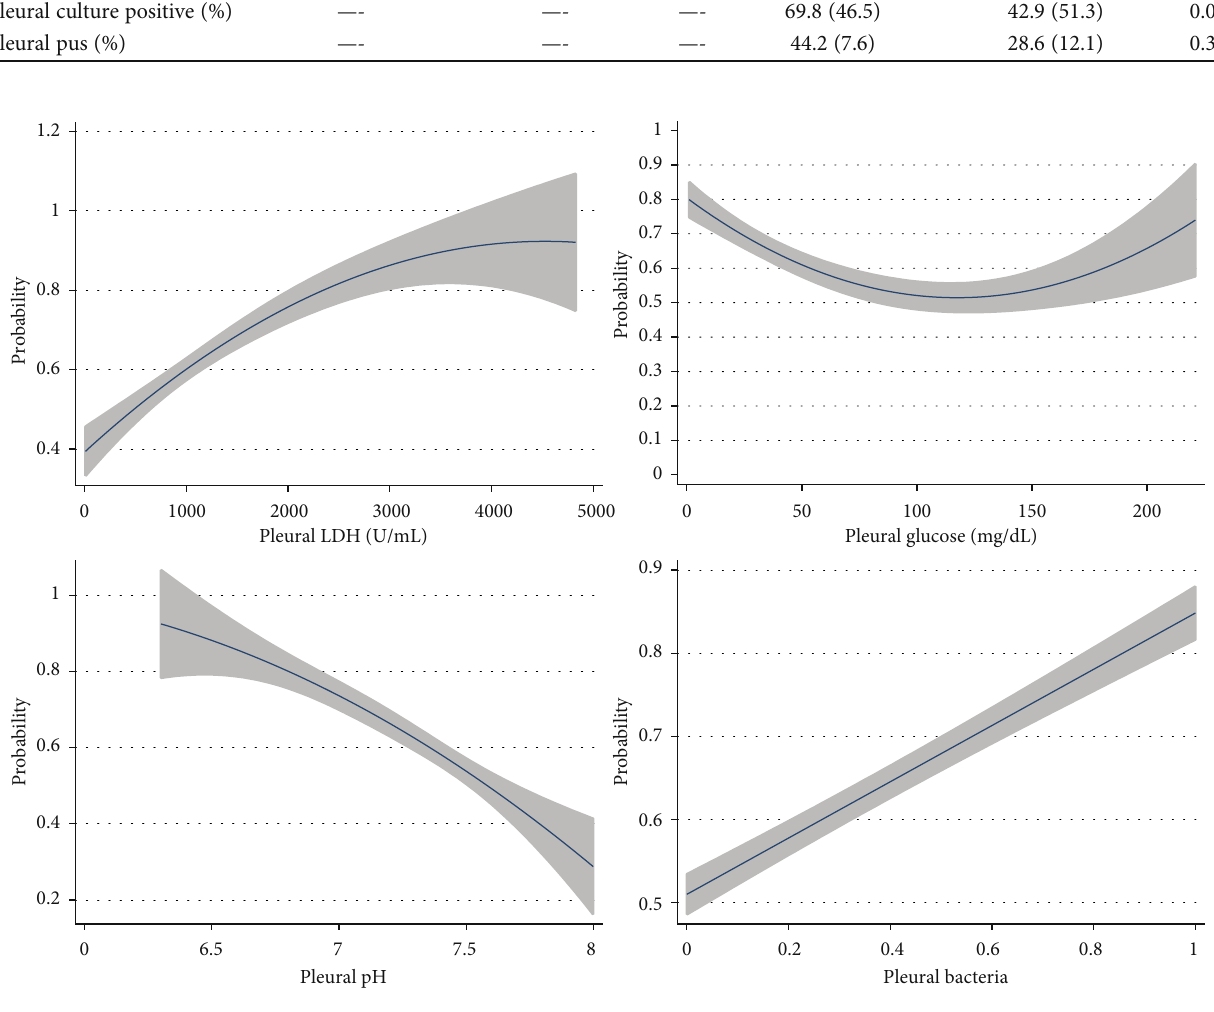
Figure 3: Logistic regression of pleural LDH, pleural glucose, pleural pH, and pleural bacteria.